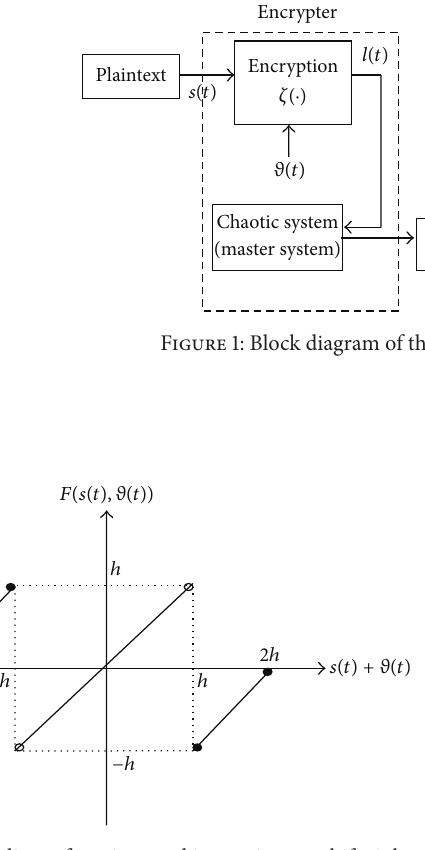
Figure 2: Nonlinear function used in continuous shift cipher.